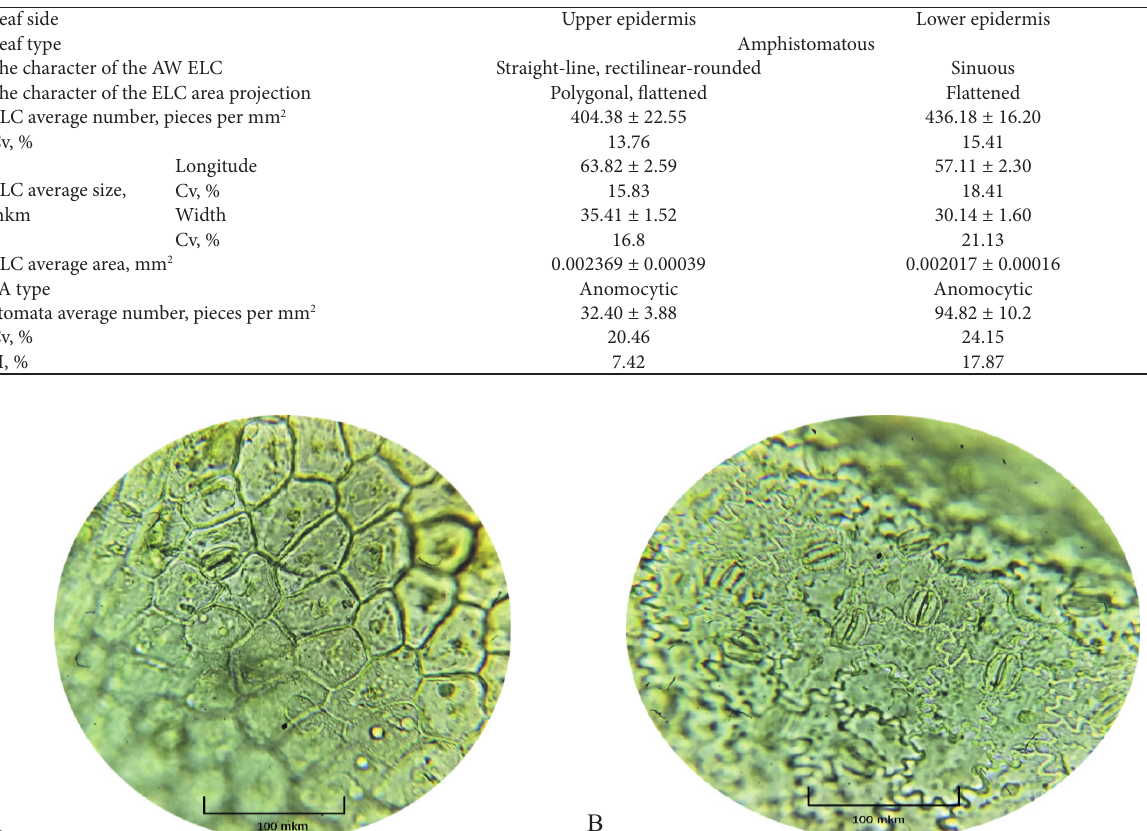
Figure 1. T. pratense leaf epidermis. A . upper epidermis; B. lower